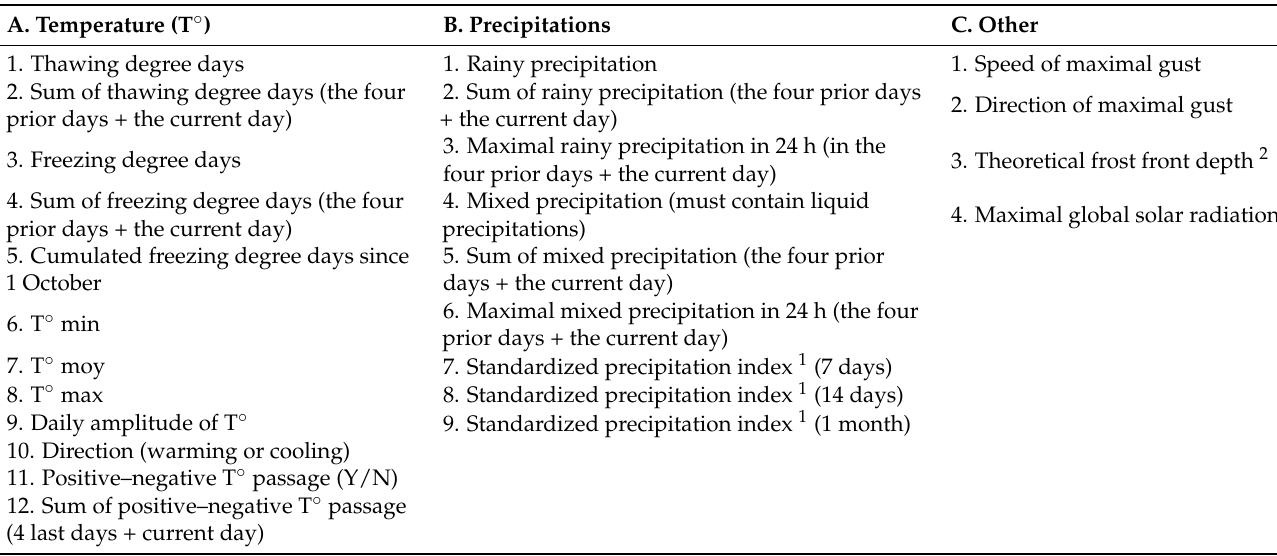
Table 4. Climatic variables included in the